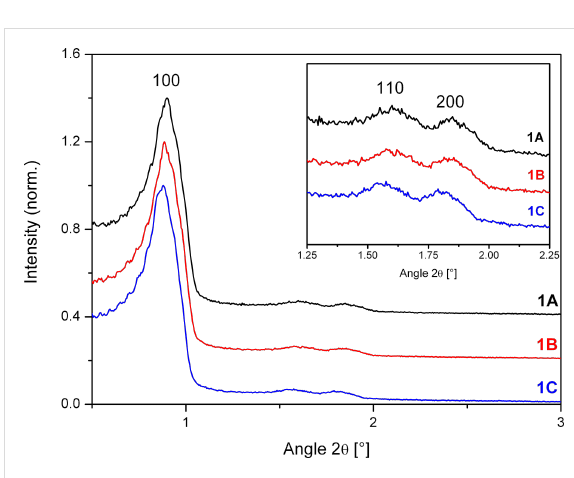
Figure 3: Small angle XRD of SBA-15 unwashed ( 1A ), after washing with 30 mL ethanol ( 1B ) and 30 mL water ( 1C ). The intensities are normalized to the (100) reflection and offset by 0.4 ( 1A ) and 0.2 ( 1B ).